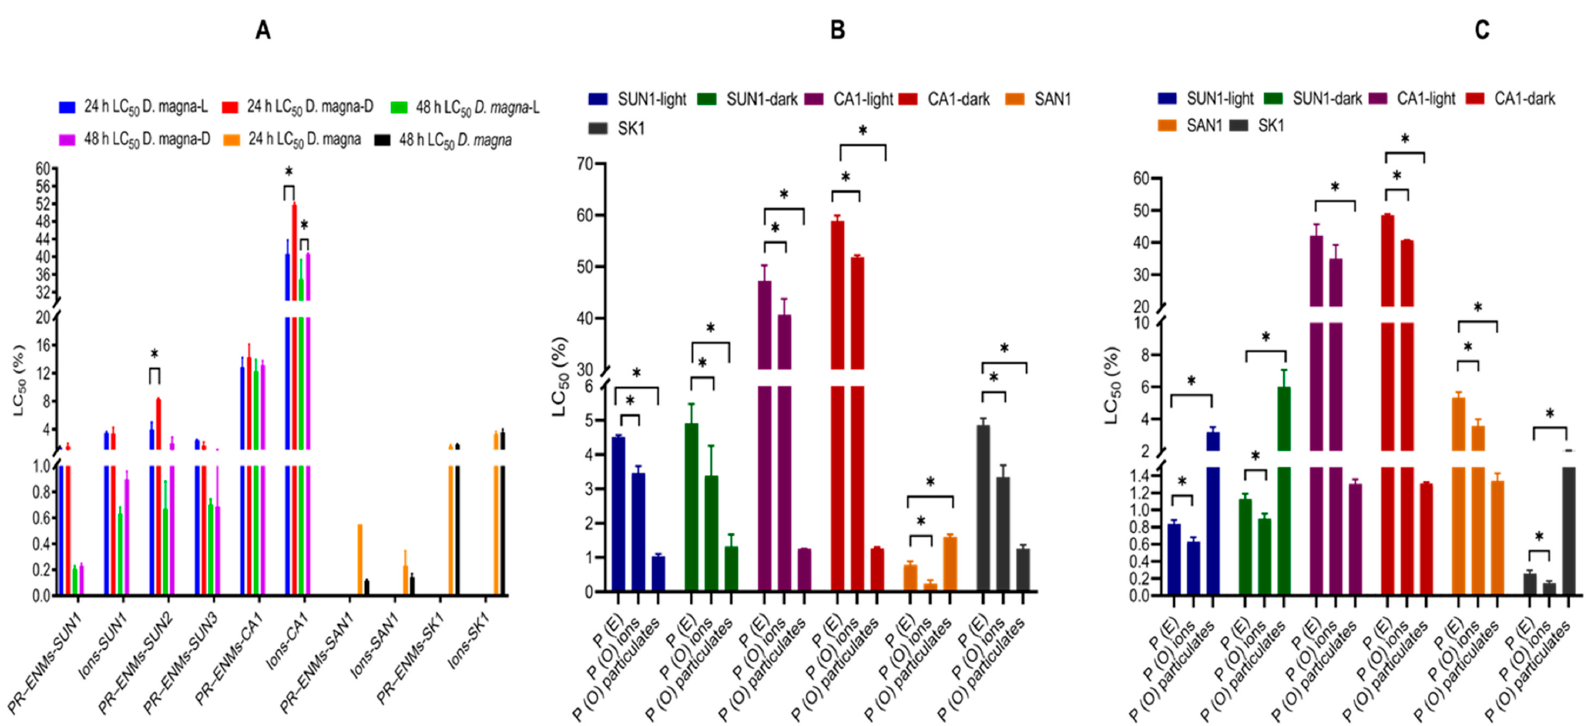
Figure 3. The 24 h and 48 h LC 50 values of D. magna after exposure to PR-ENMs and ions ( A ) and comparisons of theoretical effects (P (E)) and observed effects (P (O)) of particulates and ions on D. magna at 24 h ( B ) and 48 h ( C ) exposure. L and D on the legends of image ( A ), respectively, denote PR-ENMs and ions obtained under light and dark conditions, while * indicates the statistical difference at p -value of ≤ 0.05.